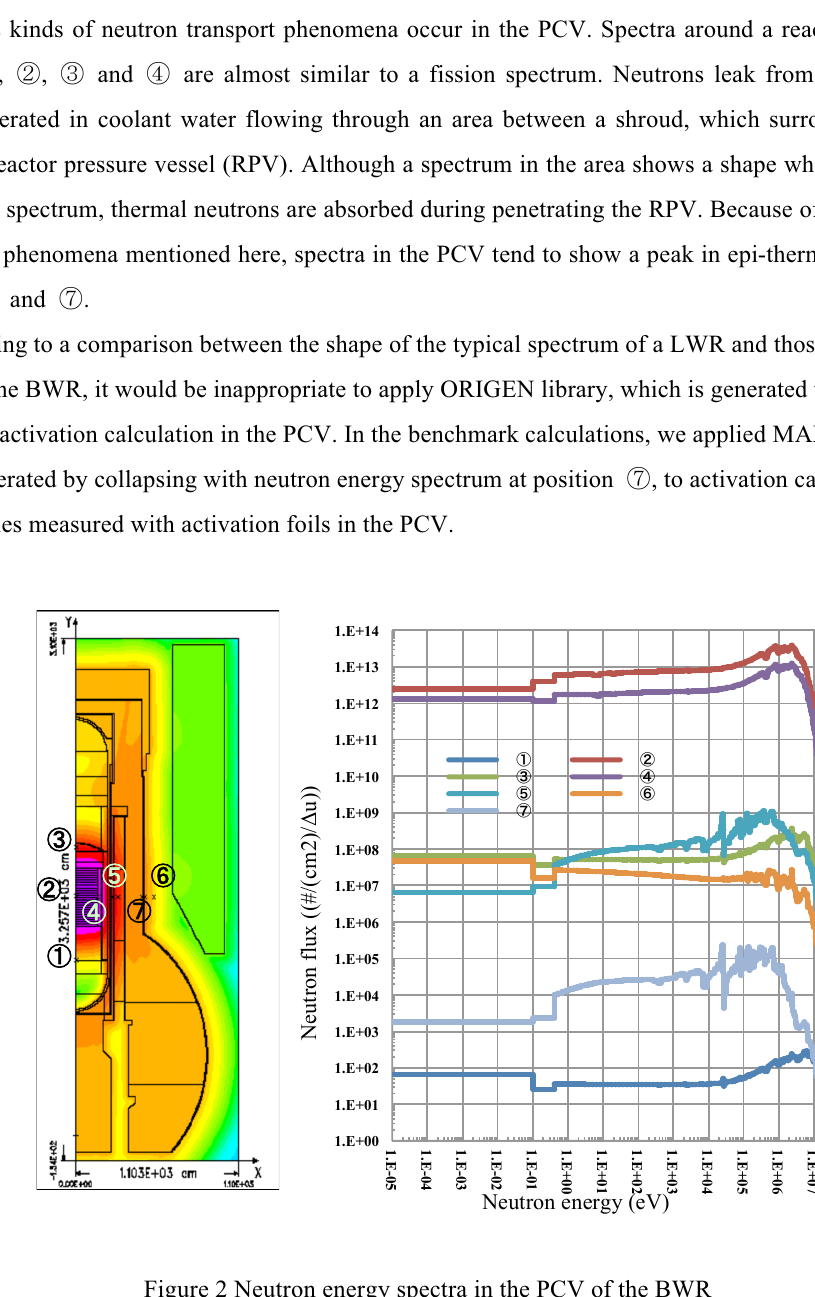
Figure 2 Neutron energy spectra in the PCV of the